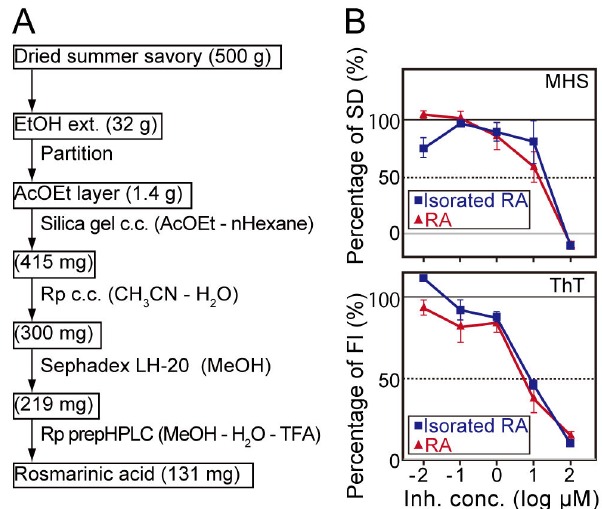
Figure 9. Isolation and identification of active compound from EtOH extract of summer savory. (A) A flow diagram of isolation steps. (B) Inhibition curves of isolated RA from summer savory (squares) and standard RA (triangles) were determined by the microliter-scale high-throughput screening (MHS) system (B, top) and the ThT assay (B, bottom). Vertical axes of the MHS system and the ThT assay are the percentage of average SD values and the percentage of average fluorescence intensity (FI) values, respectively. The EC 50 values of isolated RA and standard RA determined by the MHS system were 9.6 ± 0.1 and 11 ± 2 µM, respectively. In contrast to that, the EC values of isolated RA and standard RA 50 determined by ThT assay were 8.6 ± 0.8 and 6.3 ± 1.5 µM, respectively. Error bars represent ±SDs (n=3 separate